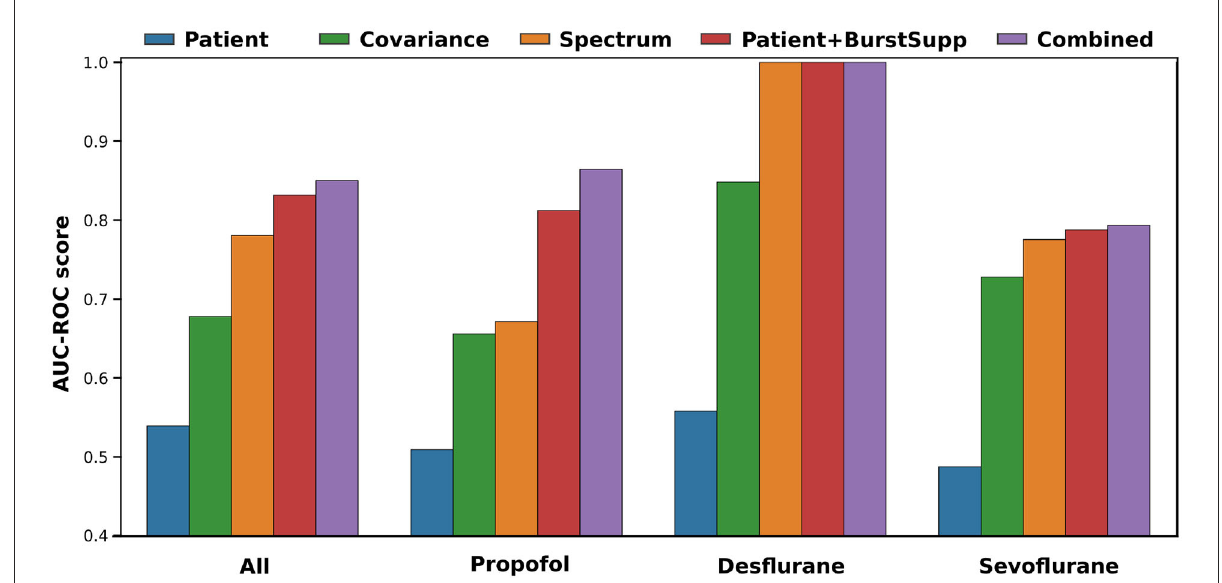
FIGURE7 Validation results on BioCog study for a model trained on the group-specific data of the SuDoCo study. All (72 patients), Propofol (20 patients), Desflurane (13 patients), Sevoflurane (38